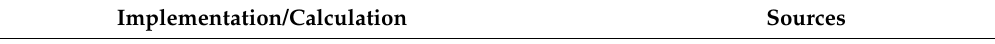
Table 1. Information of the landslide conditioning